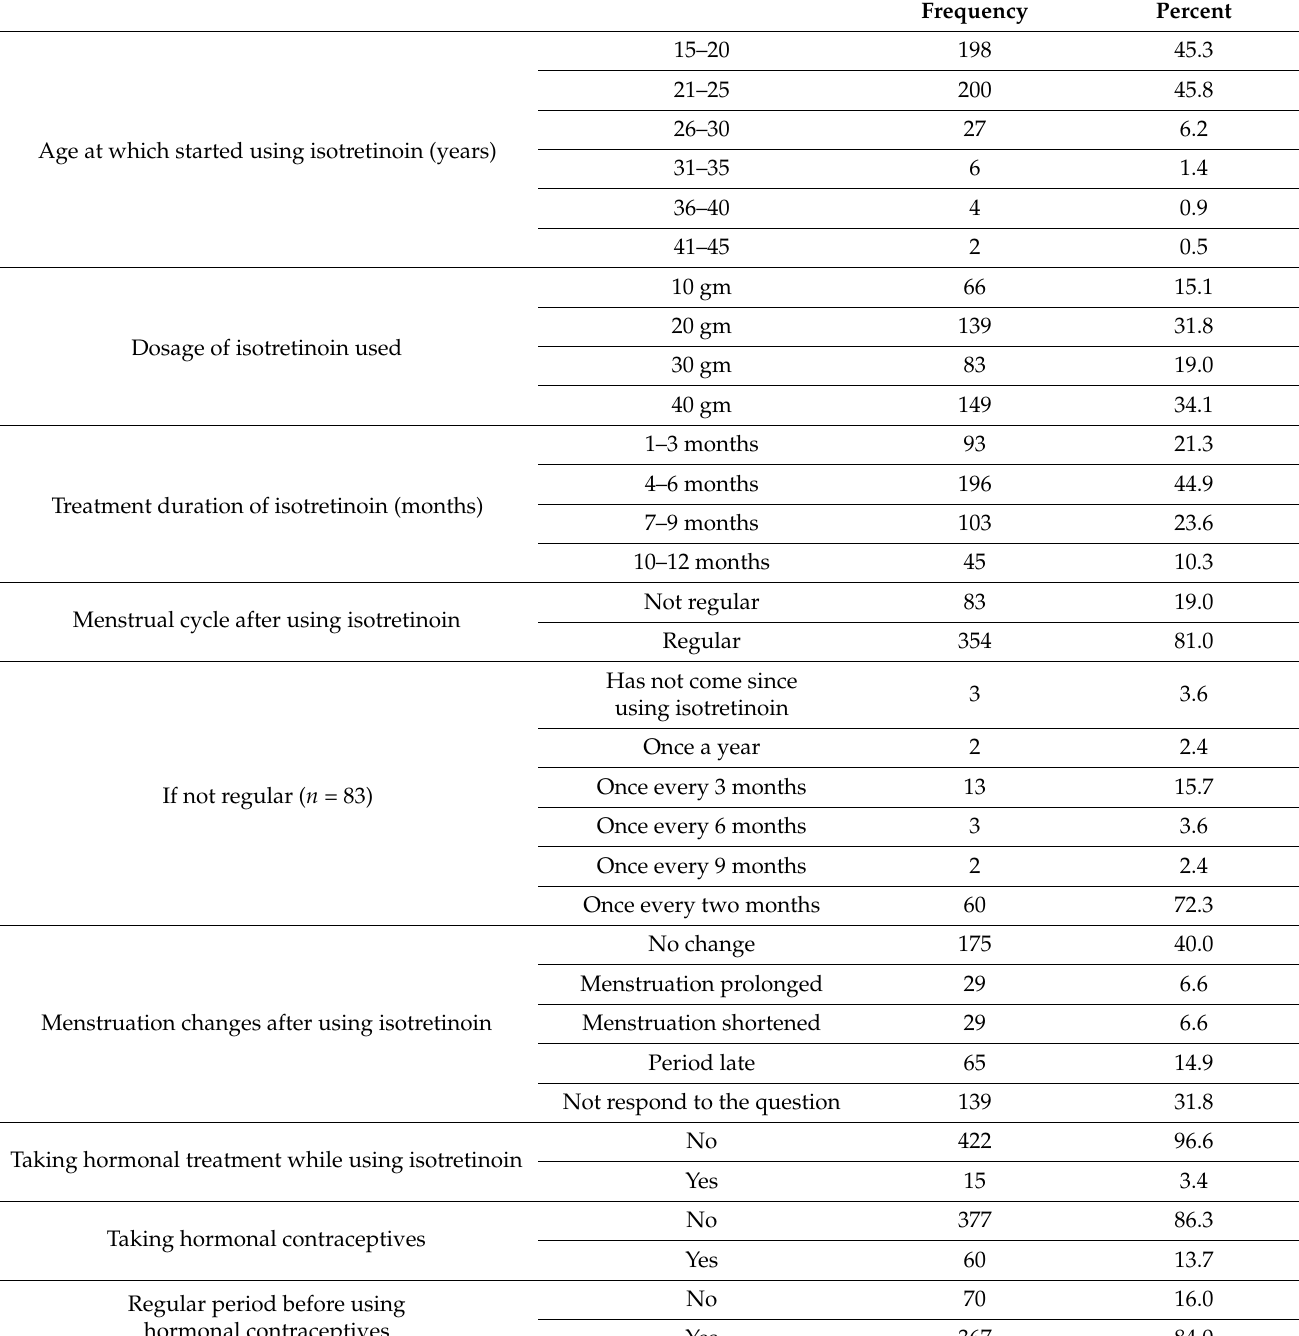
Table 2. Isotretinoin-related practices and menstrual characteristics.